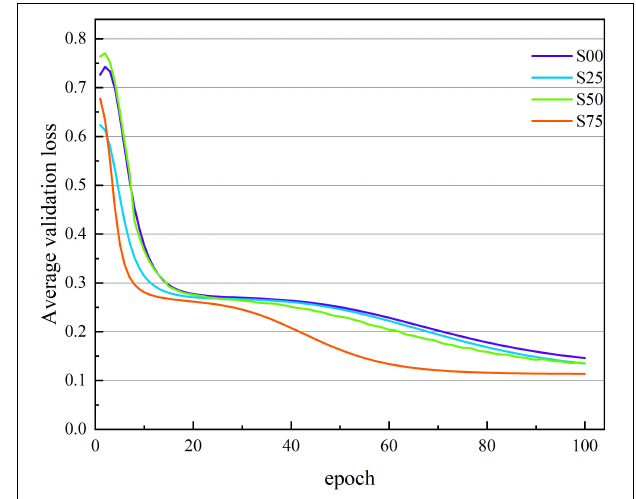
FIGURE 3 | The average verification accuracy curves of the base-model under different segmentation overlap rates. The abscissa is the number of epochs,